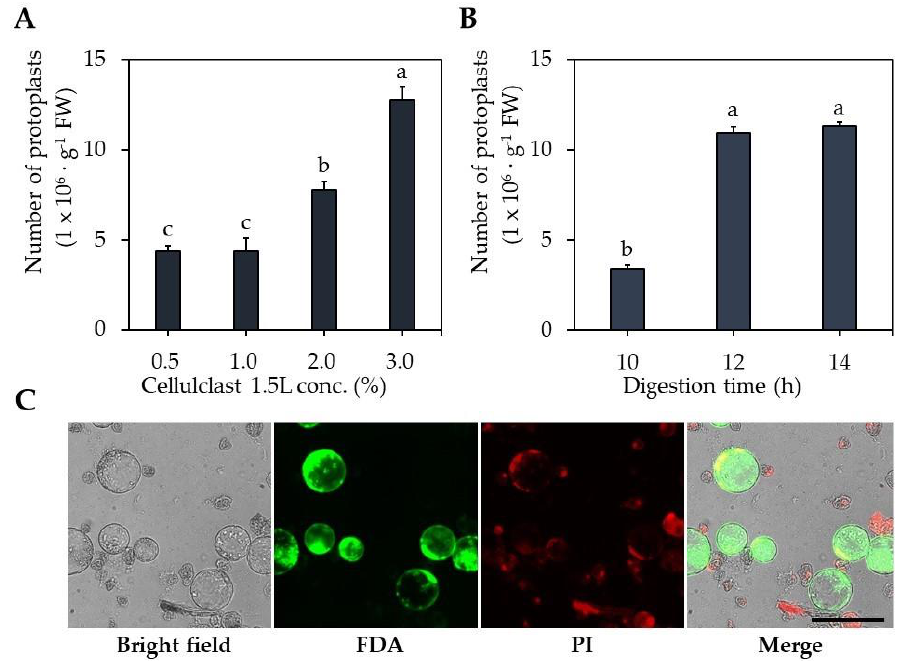
Figure 1. Optimization of carrot protoplast isolation. ( A ) Effect of Celluclast ® 1.5 L concentrations. ( B ) Effect of digestion time. ( C ) Protoplast stained with FDA (live cell, green) and PI (dead cell, red). Black scale bar = 100 µm. Different lowercase letters indicate statistically significant differences ( p < 0.05; Duncan’s multiple range test). Values are expressed as mean ± SD, the error bars represent at least three independent replicates.